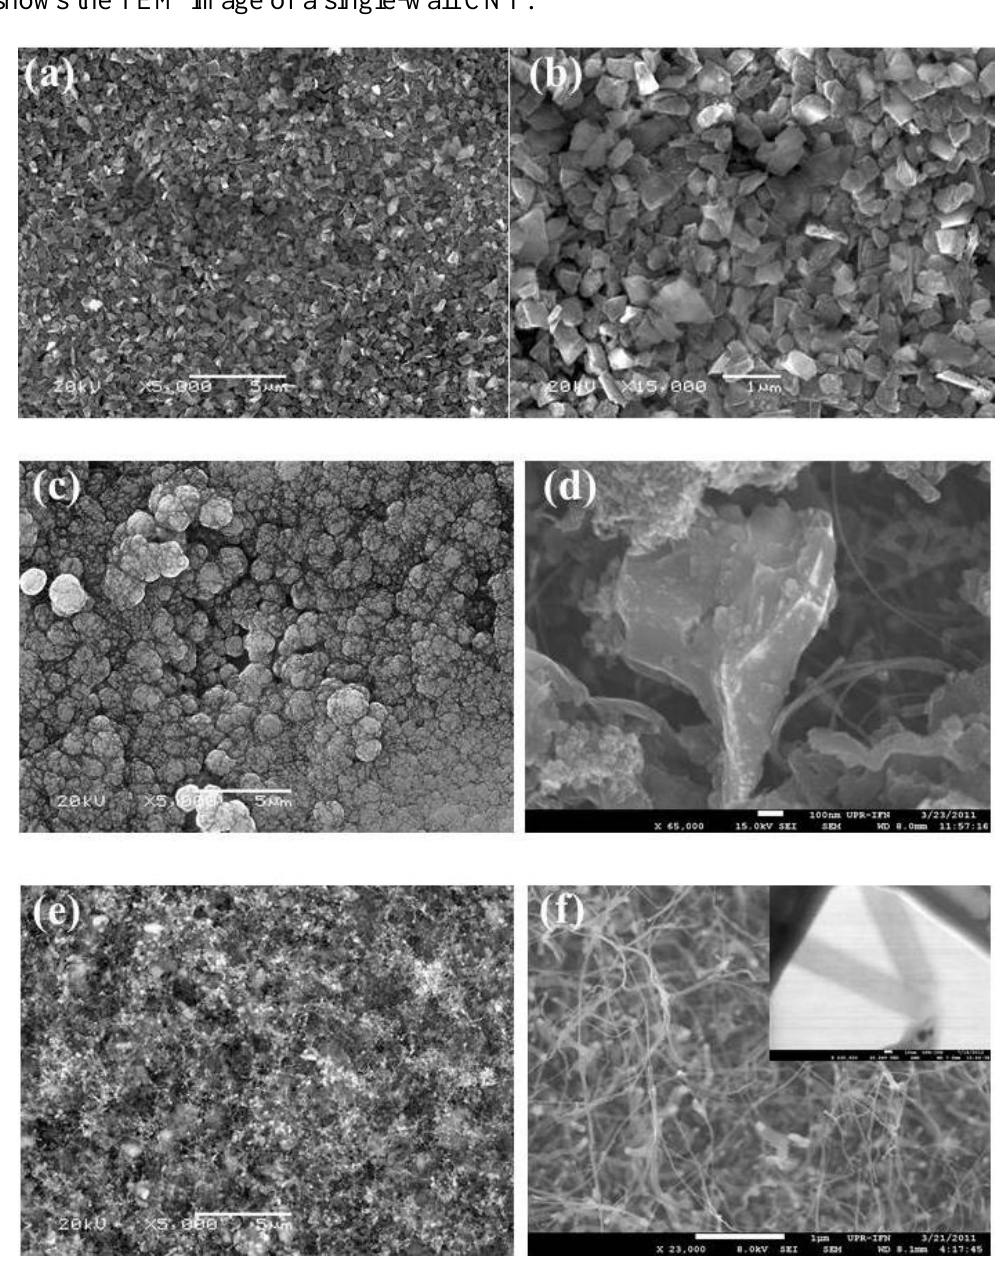
Figure 2. SEM images of materials grown on CrN-coated stainless steel substrates: ( a , b ) MCD/CrN/Steel; ( c , d ) NCD/CrN/Steel; and ( e , f ) CNT/CrN/Steel. The inset in ( f ) shows the TEM image of a single-wall